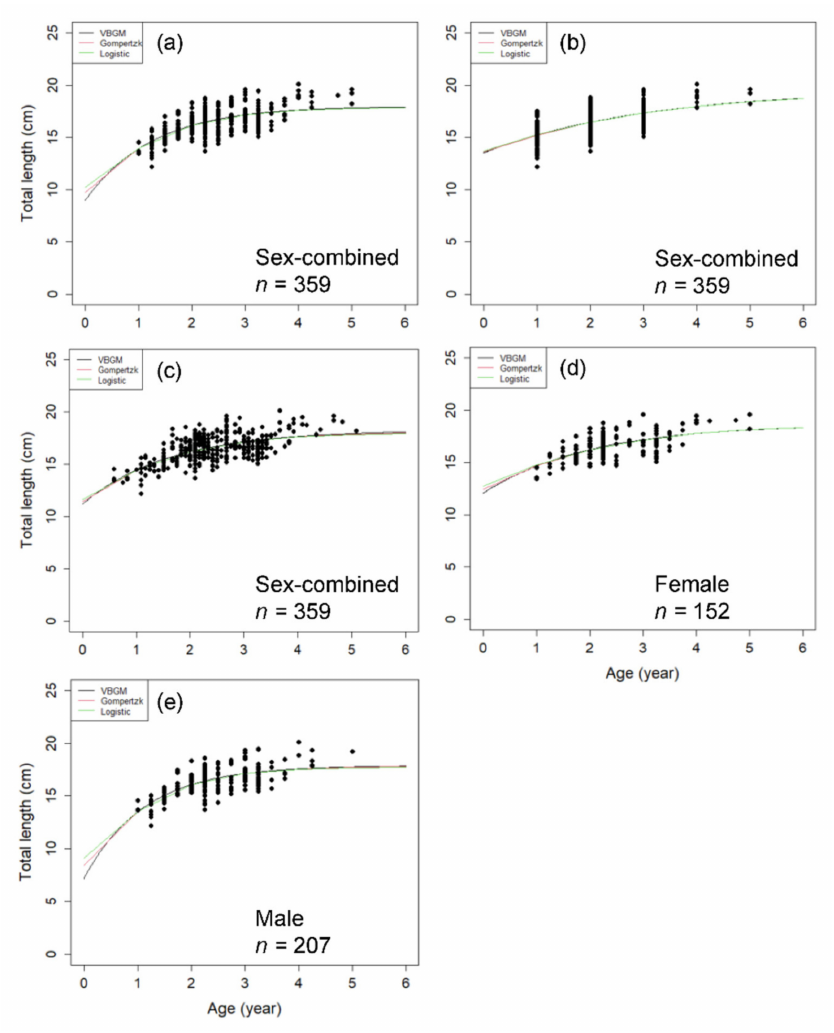
Figure 6. Age and length of sex-combined and sex-separated data and fitted growth curves of the three growth models for P. macrocephalus off southwestern Taiwan. ( a , d , e ) are the quartile of the marginal growth band method; ( b ) is the integral counting method; ( c ) is the back-calculation